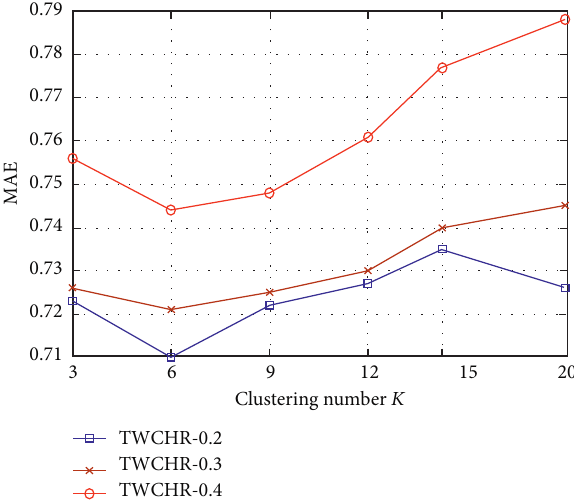
Figure 1: The influence of the information half-value period on the recommendation algorithm.